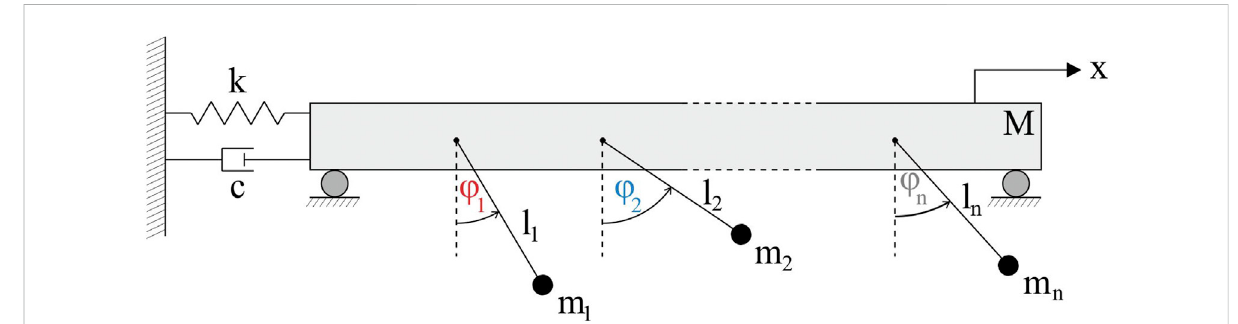
FIGURE 1 The model of n oscillating pendula with masses m i and lengths l i suspended on the horizontally oscillating beam. The beam of mass M is connected with the support by the spring of stiffness k and the damper of damping coef fi cient c . Variable x stands for displacement of the beam, while φ i is angular displacement of i – th pendulum. The paper uncovers various types of behaviours than can be found for different sizes of the